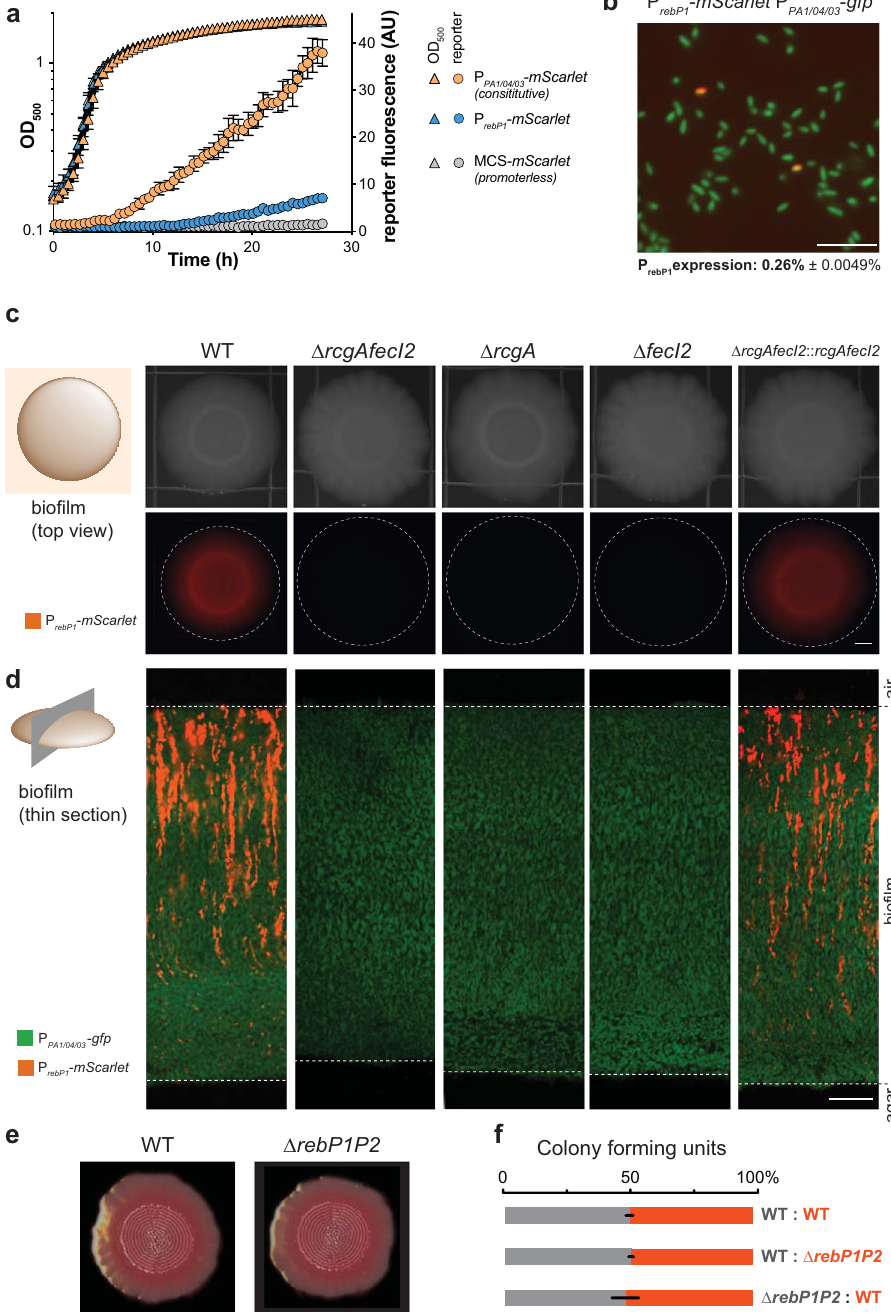
Fig. 3 Expression of PA14 R-body genes is stochastic and controlled by RcgA and FecI2, and does not confer a competitive advantage during growth in bio fi lms. a Reporter strain growth and expression of mScarlet under the control of the rebP1 promoter (P rebP1 - mScarlet ), no promoter (MCS -mScarlet ), or a constitutive promoter (P PA1/04/03 - mScarlet ) in shaken 1% tryptone liquid cultures incubated at 25 °C. n = 6 biological replicates from two experiments. Data are presented as mean values ± SD. b Image of fl uorescence from PA14 cells containing P rebP1 transcriptional reporter construct (P rebP1 - mScarlet ) and a constitutive promoter driving gfp (P PA1/04/03 - gfp ) in shaken 1% tryptone liquid cultures grown at 25 °C for 16 h. Image is representative of six replicates from three experiments. Scale bar is 10 µ m. c Left: Schematic indicating plane of view, and legend de fi ning fl uorescence signal, in right-hand panels. Right: Bright- fi eld and fl uorescence microscopy images of 3-day-old bio fi lms formed by the indicated genotypes, containing the P rebP1 transcriptional reporter construct (P rebP1 - mScarlet ). Dotted lines demarcate the edges of bio fi lms. Scale bar is 2 mm. d Left: schematic indicating plane of view, and legend de fi ning fl uorescence signals, for right-hand panels. Right: representative images of thin sections prepared from 3-day-old bio fi lms formed by strains containing P rebP1 - mScarlet and constitutively expressing GFP (via P PA1/04/03 - gfp ). Dotted lines denote the interfaces with air (top) and agar (bottom). Scale bar is 20 μ m. e Three-day-old WT and Δ rebP1P2 bio fi lms grown on colony morphology medium. Images are representative of nine replicates from three experiments. Scale bar is 4 mm. f Relative percentages of colony forming units (CFUs) of each strain obtained from mixed-strain colony bio fi lms grown for 3 days. Each mixed bio fi lm contained one unlabeled strain and one constitutively expressing mScarlet. Error bars represent standard deviation of biological